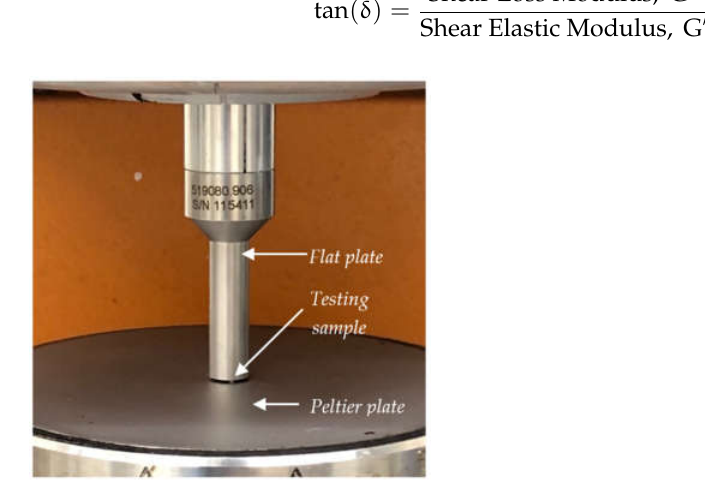
Figure 6. Apparatus used for rheological characterization.